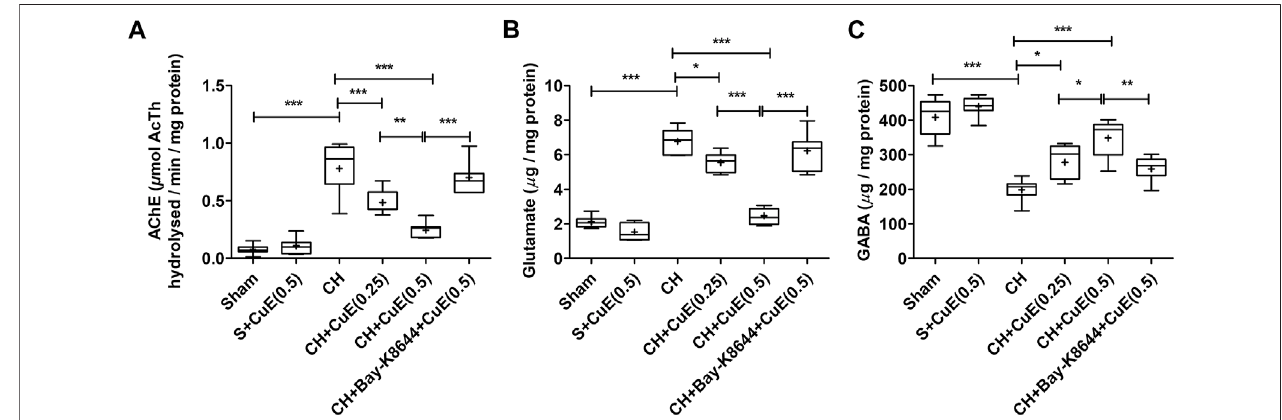
FIGURE 7 | CuE post-treatment (0.25 and 0.5 mg/kg, p.o. ) for 28 days decreased AChE activity and ameliorated neurotransmitter levels against CH. CuE signi fi cantlylowered (A) AChEactivity, (B) glutamate levels, and enhanced (C) c -aminobutyric acid(GABA) level inthe brain ofrats exposed toCH on day 1. Bay-K8644 attenuated amelioration of neurotransmitters by CuE. Box and whisker plots (Tukey) show mean (+), median (bold horizontal line), quartiles (box), and total range (whisker) ( n (cid:1) 7). * ( p < .05), ** ( p < .01), *** ( p < .001)